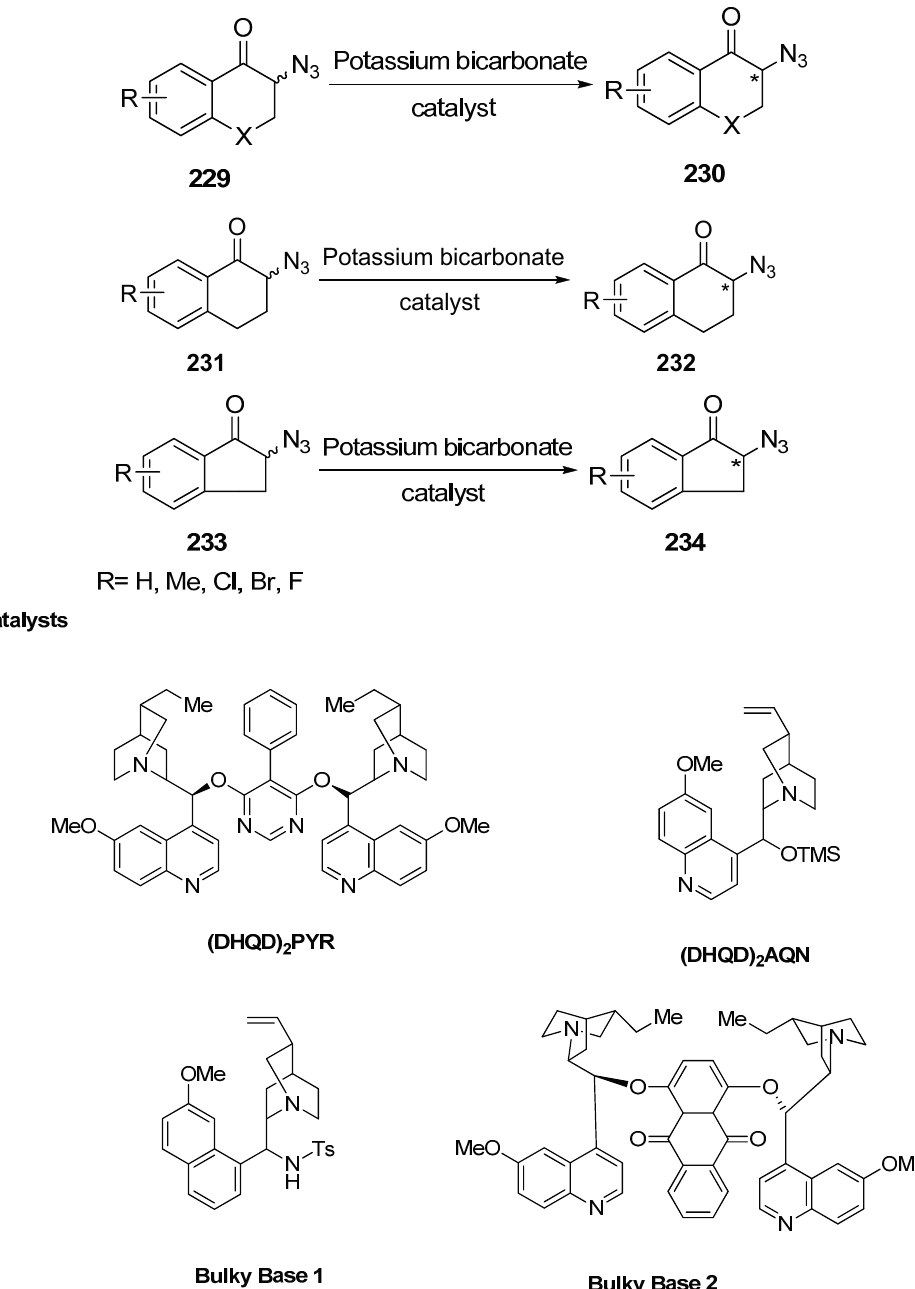
Scheme 88. Deracemization of chiral cyclic α -azido